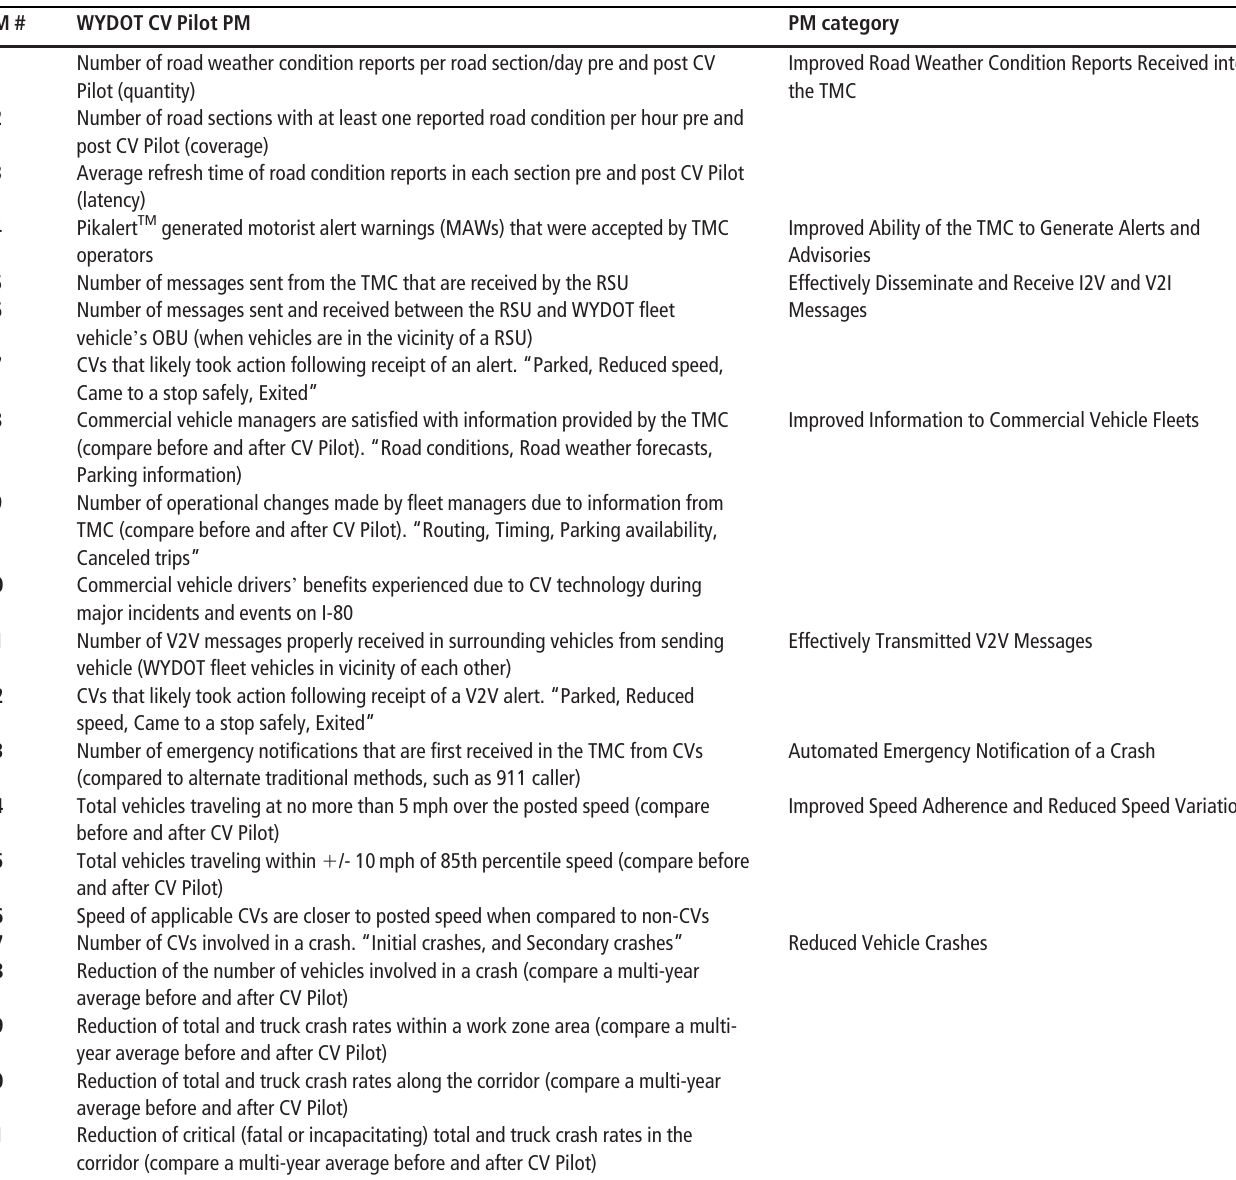
Table II Summary of performance measures (PMs) and their categories (Kitchener et al. ,